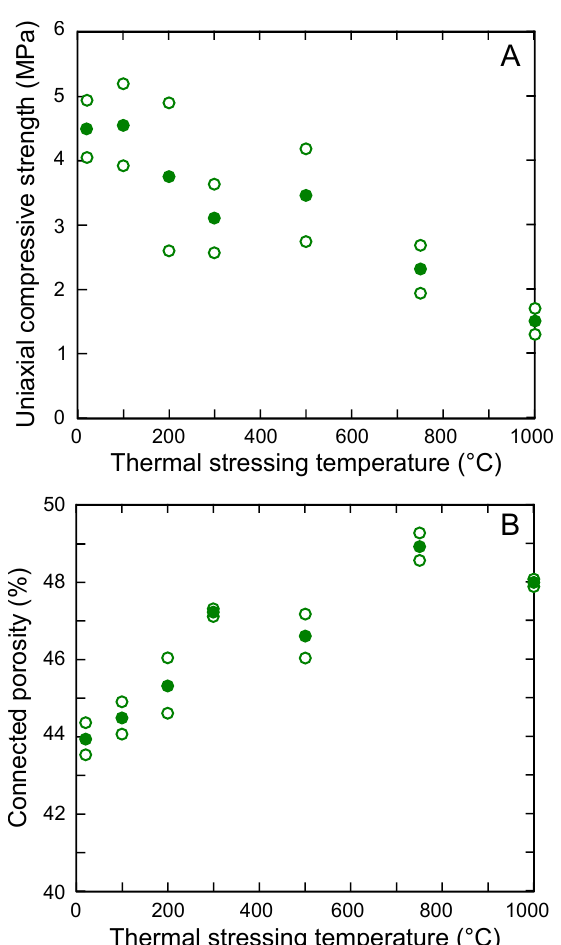
Figure 6: [A] Uniaxial compressive strength (UCS) as a function of thermal stressing temperature for Mt. Epomeo Green Tu ff (MEGT) (open symbols). The filled symbols are the averages of two measurements (Ta- ble 2). [B] Connected porosity as a function of thermal stressing temperature for MEGT (open symbols). The filled symbols are the averages of two measurements (Table